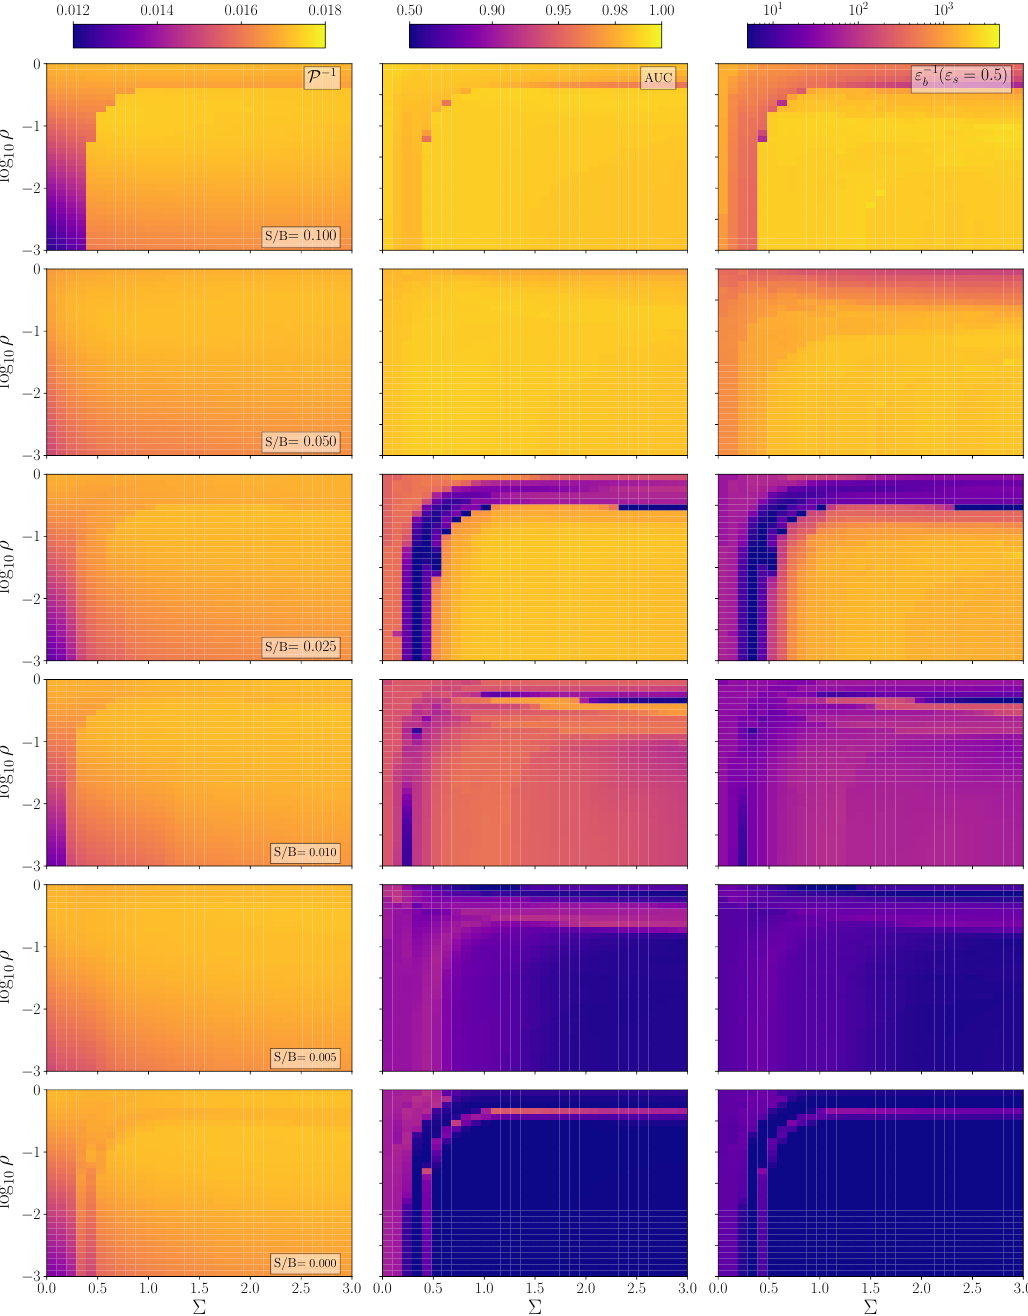
Figure 22 . Results of LDA models in the ( (cid:26); (cid:6)) parameter-space trained on samples of mixed W 0 and QCD events using mass basis observables m 0 and m 1 =m 0 , with di(cid:11)erent S/B ratios (one per row). Each row contains plots of perplexity, AUC, and inverse mis-tag rate at (cid:12)xed e(cid:14)ciency. See text for details.